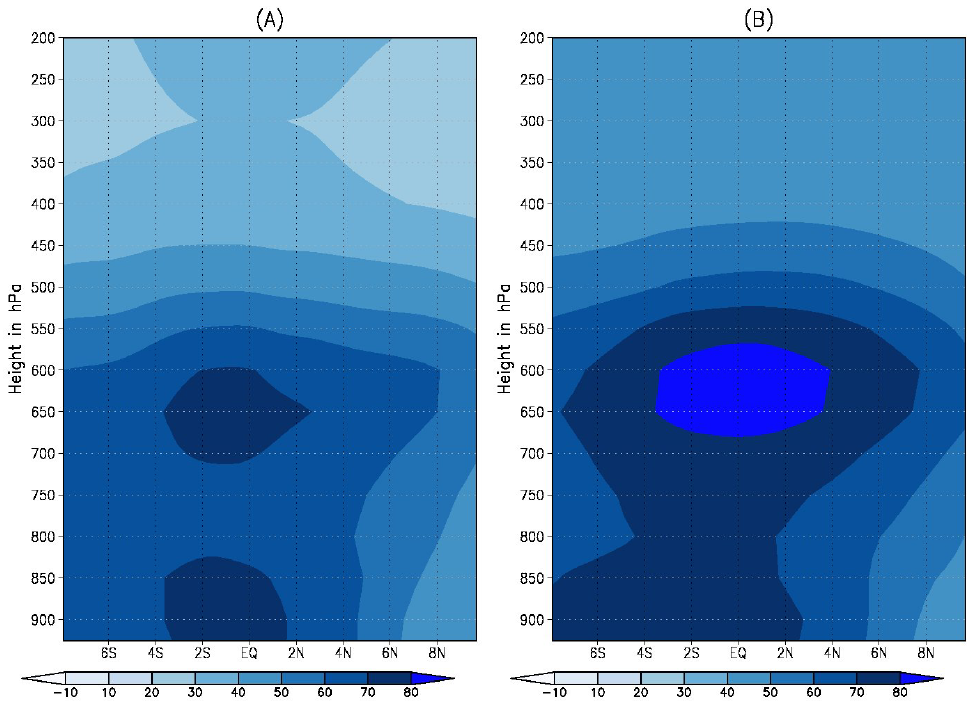
Figure 3. North to south vertical transect of Relative Humidity (%) over the